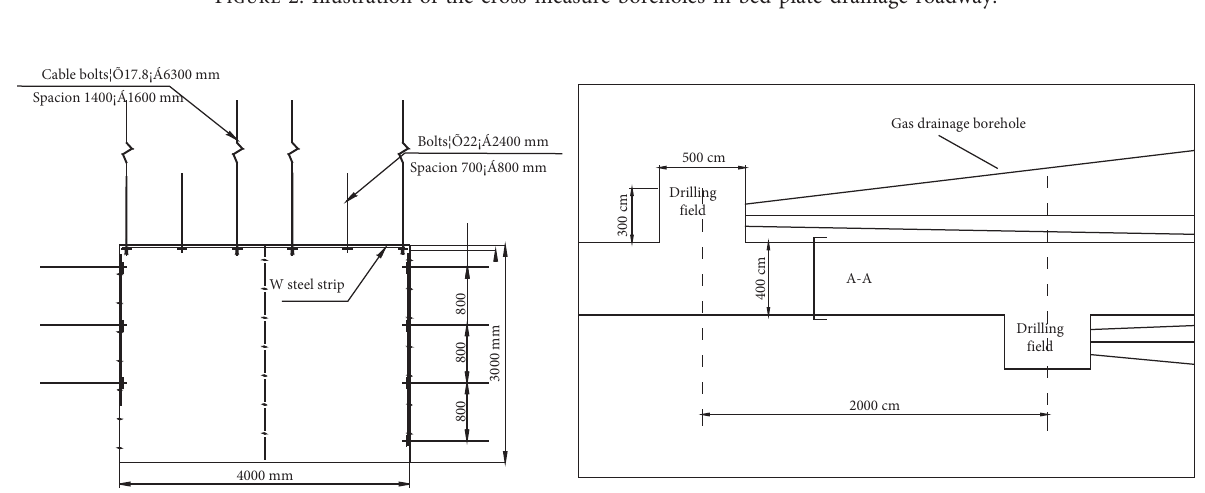
Figure 3: Distribution of drilling fields and drainage boreholes in the gas drainage